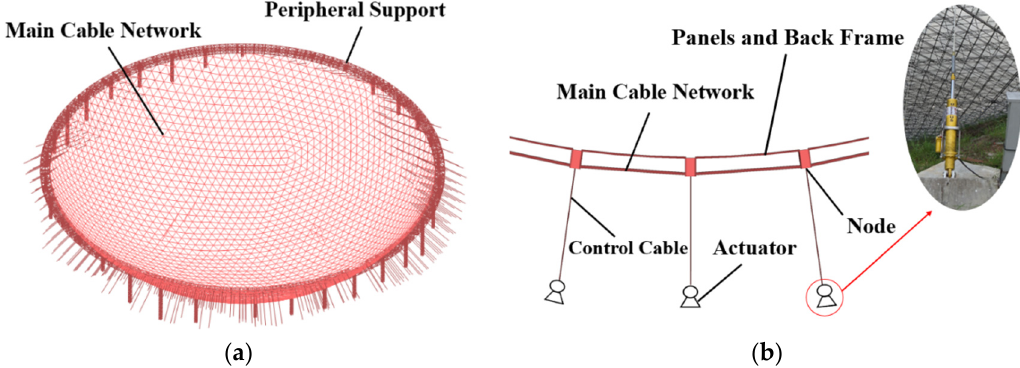
Figure 1. Overall cable-net structure of the FAST: ( a ) numerical model; ( b ) local detailed cable-net structure.